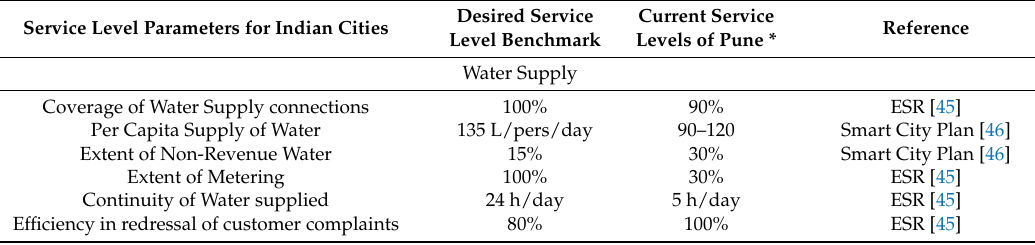
Table 2. Gaps in infrastructure and basic service levels in Pune.